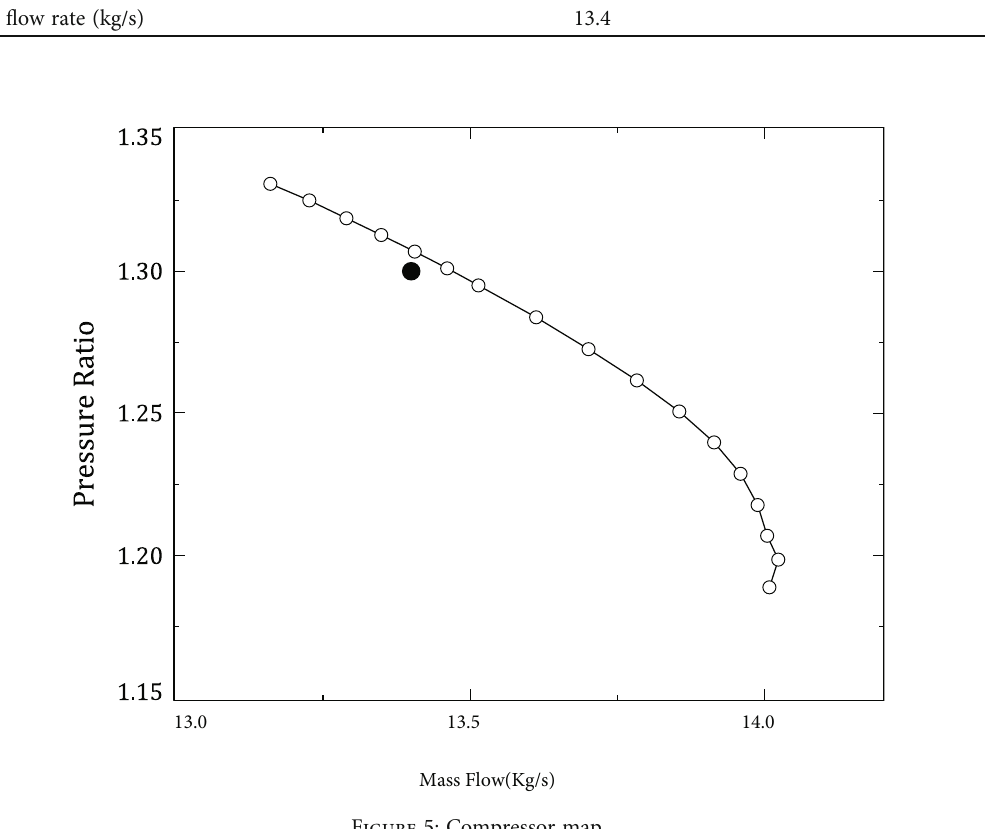
Figure 5: Compressor